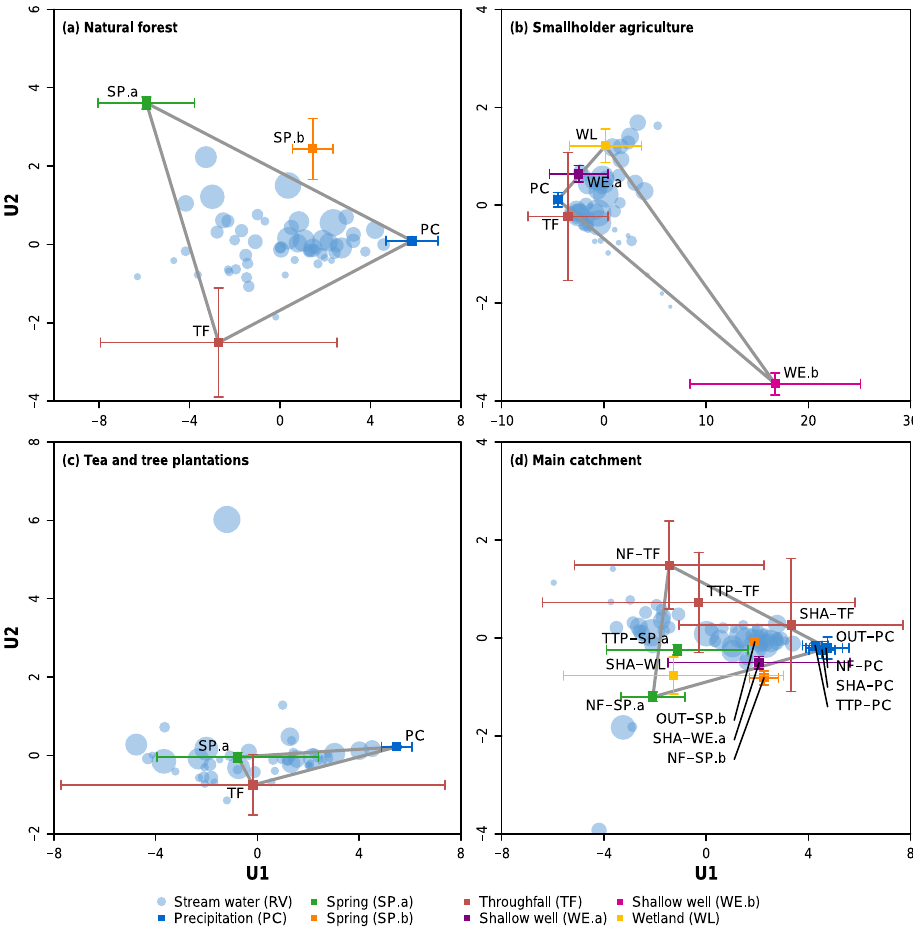
Figure 4. Projection of endmembers in the two-dimensional (U1 and U2) mixing space of stream water samples of the (a) natural forest (NF), (b) smallholder agriculture (SHA), and (c) tea and tree plantation (TTP) sub-catchments and (d) the main catchment (OUT) between 15 October 2015 and 21 October 2016 in the South-West Mau, Kenya. The size of the symbol for stream water represents the relative discharge at the time of sampling (larger symbol means higher